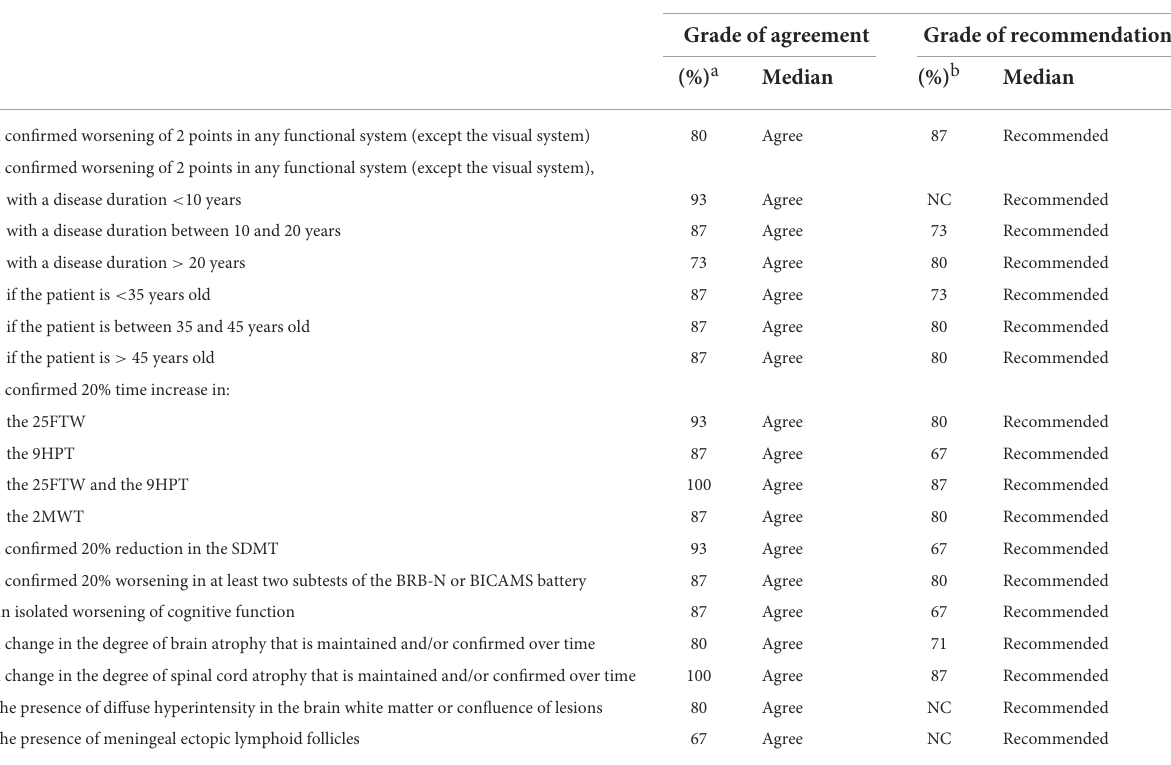
TABLE 1 Variables whose isolated change allows to suspect diagnosis of